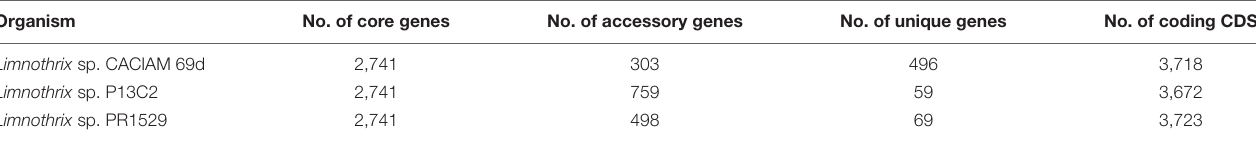
TABLE 3 | Number of protein sequences for representatives of core, accessory and unique orthologous clusters present in Limnothrix genomes, excluding Limnothrix rosea IAM M-220. Organism No. of core genes No. of accessory